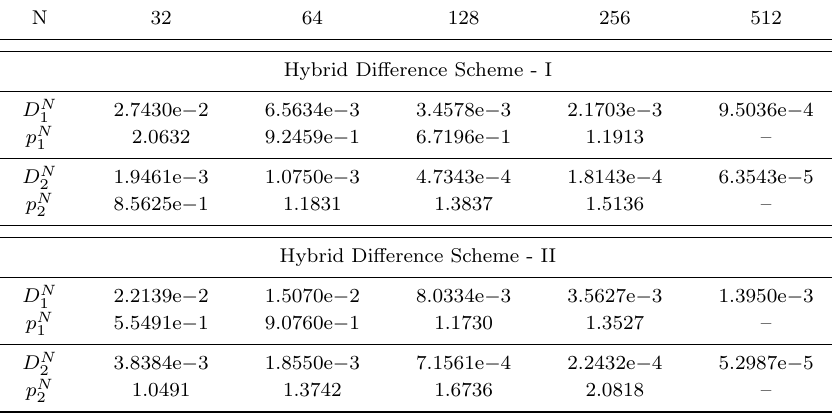
,p N and D N ,p N for the Example 2 in the fine mesh region. 1 1 2 2